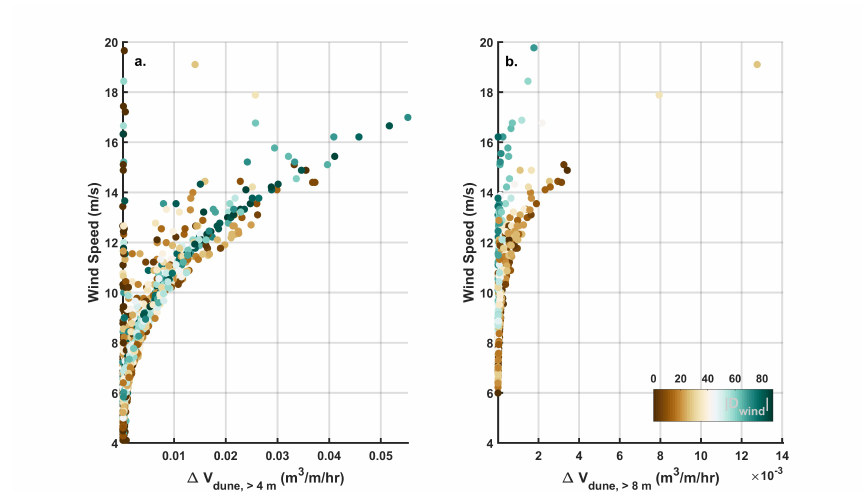
Figure 9. Hourly Windsurf simulated ∆ V dune above the 4 m contour ( a ) and 8 m contour ( b ) resulting from aeolian processes (marine-related ∆ V dune are excluded) plotted against wind speed. Colors represent the absolute value of wind direction relative to